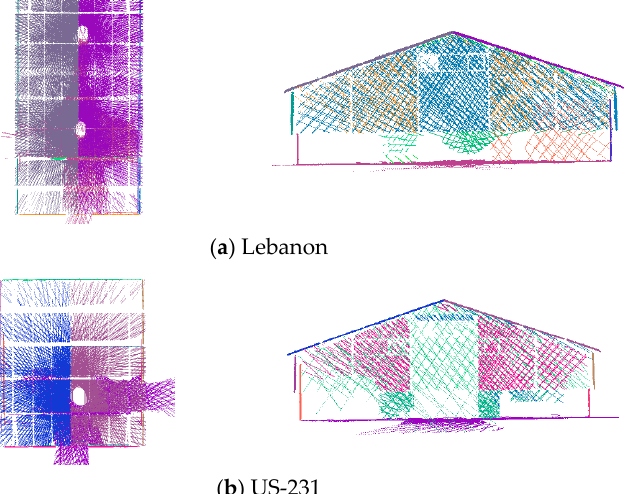
Figure 24. Fine-registered point cloud from the proposed SLS-based approach, visualized from top view ( left ) and front view ( right ). Only the features used in registration are shown (point clouds are colored by their respective planar features).